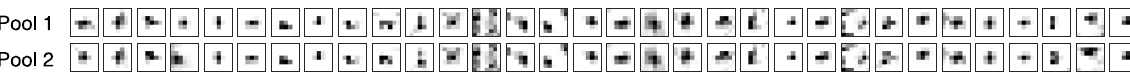
Fig 7. Size-tuning in silico experiments and spatially extended DN control models. A . inset : Prediction of the best DN model (chosen by validation set accuracy) for all neurons to gratings of increasing size. The gratings’ properties were determined from the units’ optimally stimulating Gabor pattern. As grating diameter increased, only very few neurons showed mostly weak suppression. Predictions normalized to maximum response per neuron. Suppression index measures asymptotic suppression relative to the maximum prediction A . main panel : Across all neurons and the ten best DN models (chosen by validation set accuracy), almost no neurons show significant surround suppression. B . Test set performance of the ten best performing DN models. The model’s performance rapidly decreases for spatially increasing normalization pool size (in units of visual angle in degrees). The best model on the validation set is indicated by a blue dot. C . & D . Weights of the spatial normalization pool for the best performing model with pool size of ( C .) 1.06˚ of visual field (5 px × 5 px) and ( D .) 1.34˚ of visual field (7 px × 7 px; all evaluated in terms of the validation set accuracy). For each feature (columns), the two components (rows) of the in total 32 spatial normalization pools are shown. Darker color corresponds to higher weights. Both components are similar. B . insets : Average across features and normalization pool components. The model learned normalization from the receptive field center (on average).